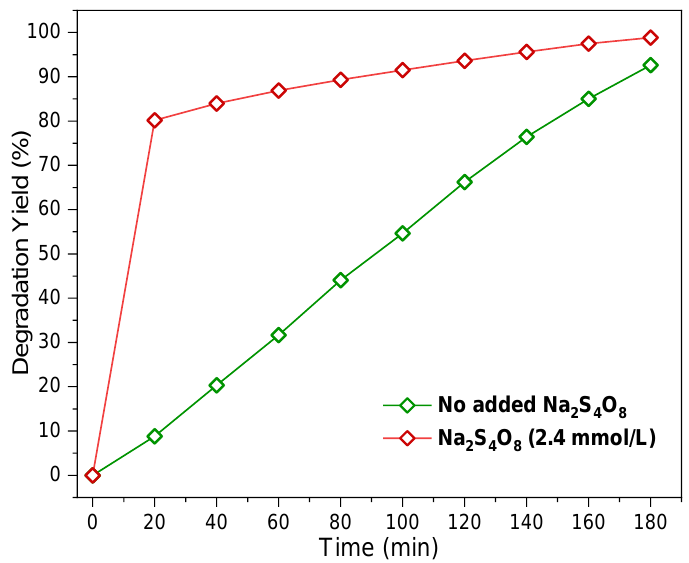
Figure 10. Effect of persulfate on the photodegradation of 500 mL BPB solution (10 ppm) with 100